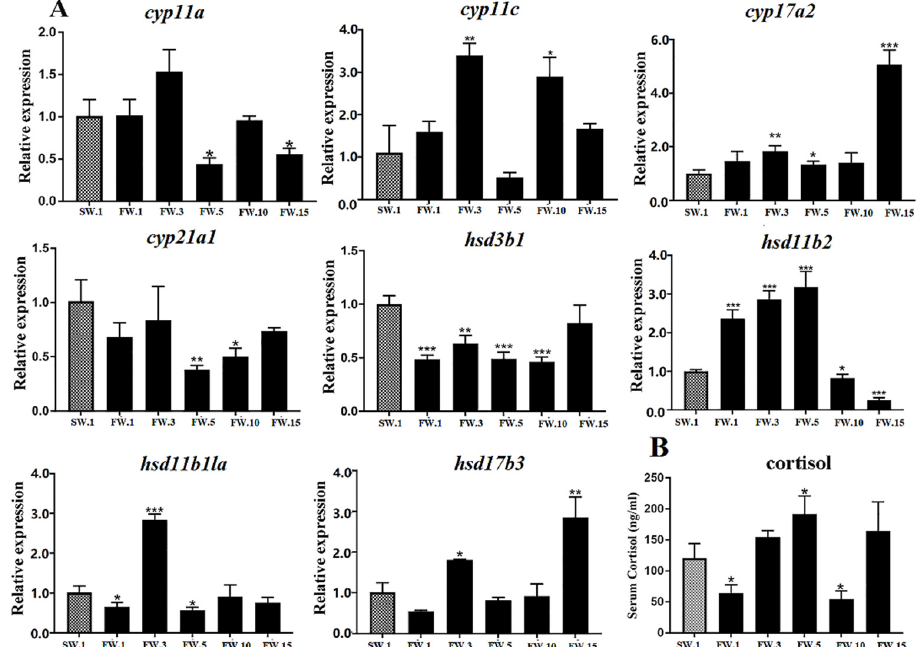
Figure 5. Cortisol synthesis regulation in the head kidney of male L. maculatus in response to salinity change. ( A ) Expression of candidate steroidogenic genes in the head kidney of male L. maculatus . ( B ) Serum cortisol levels in male L. maculatus after the freshwater acclimation. * represents p < 0.05; ** represents p < 0.01; *** represents p < 0.001.